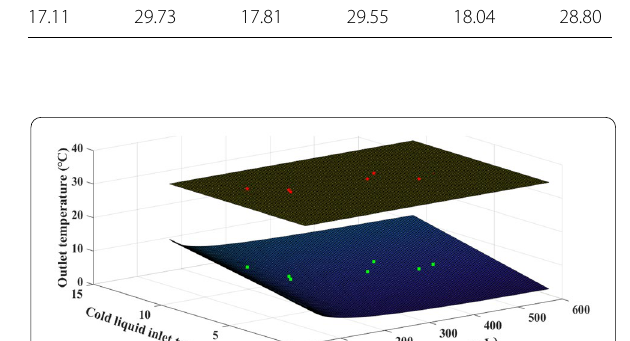
Table 6 Inlet and outlet temperatures (°C) Inlet